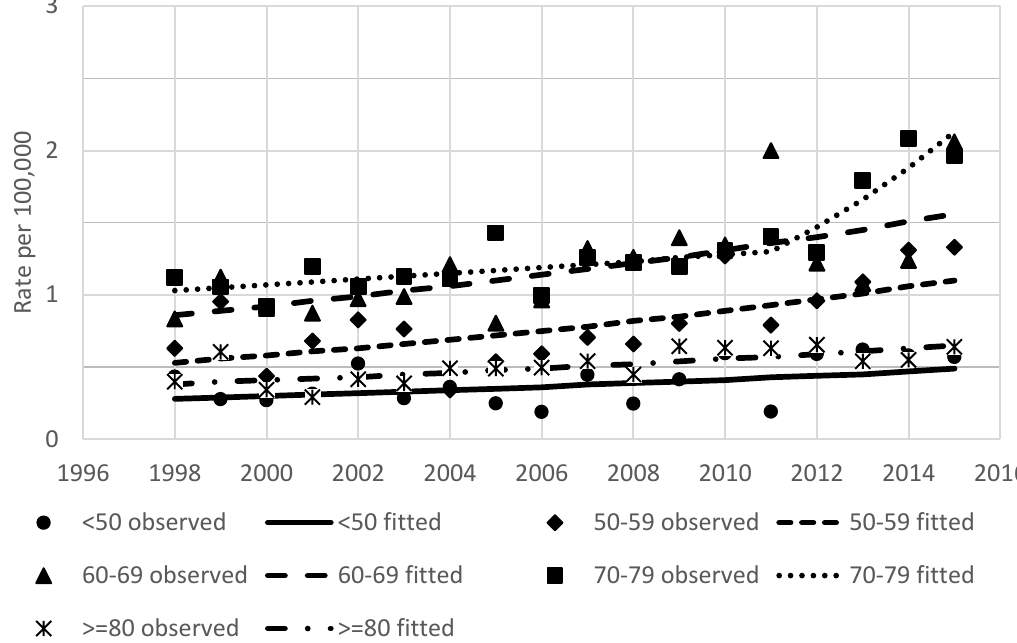
Figure 4. Age-standardized incidence rates of primary liver cancer by age group in Lithuania between 1998 to 2015.